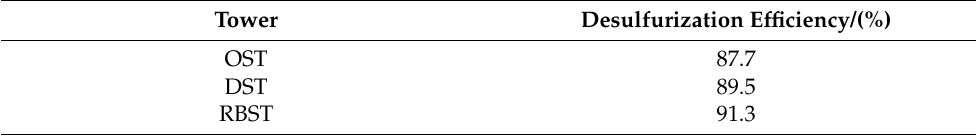
Table 6. Desulfurization